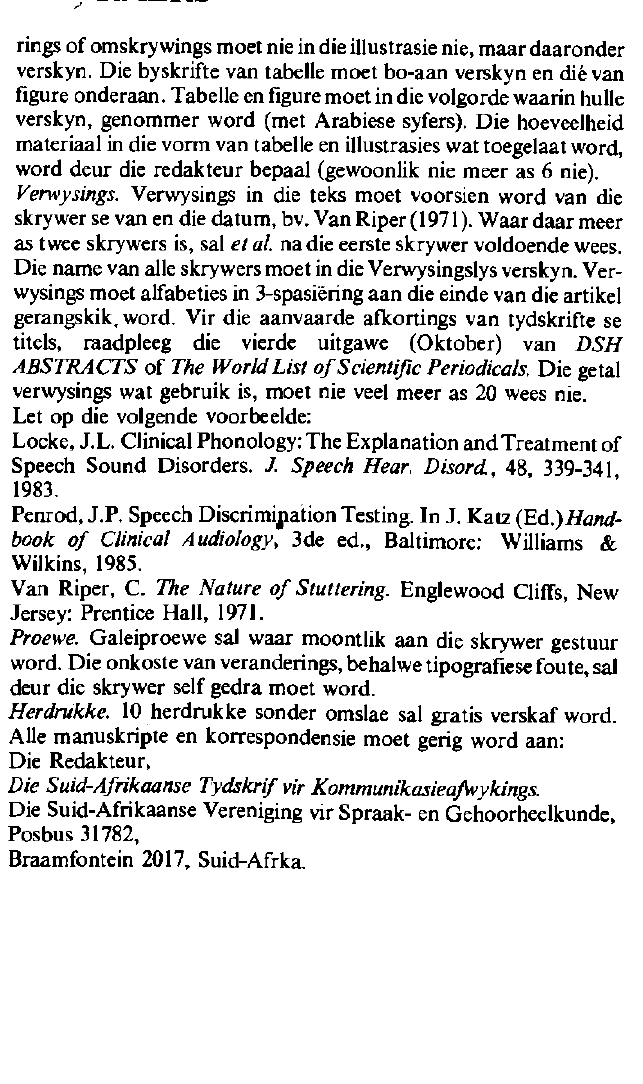
figure onderaan. Tabelle en figure moet in die volgorde waarin hulle verskyn, genommer word (met Arabiese syfers). Die